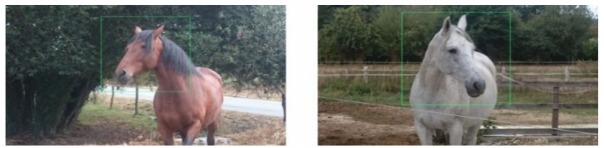
Figure 4. Detector predictions.